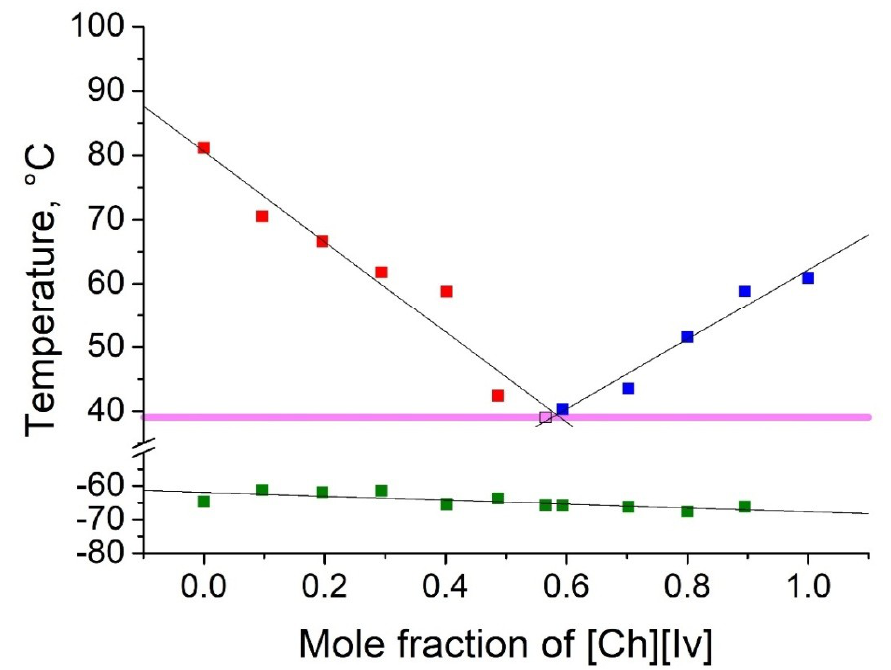
Figure 2. Temperature composition phase diagram for the mixture of [Ch][Ac] and choline 2-methylbutyrate ([Ch][2mb]), and their individual components at 0.0 and 1.0 mole fractions. Legend: (cid:4) —melting point of the excess component [Ch][Ac] in the mixture; (cid:4) —melting point of the excess component [Ch][2mb] in the mixture; (cid:4) —glass transition temperature; (cid:4) —eutectic point; – eutectic transition line.